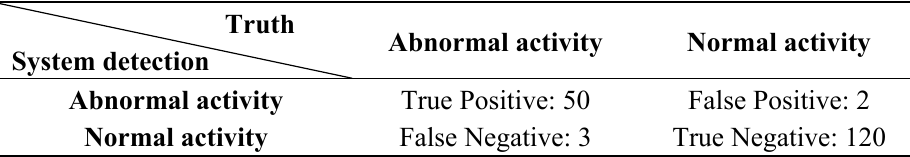
Table 1. Experimental results with our test videos.